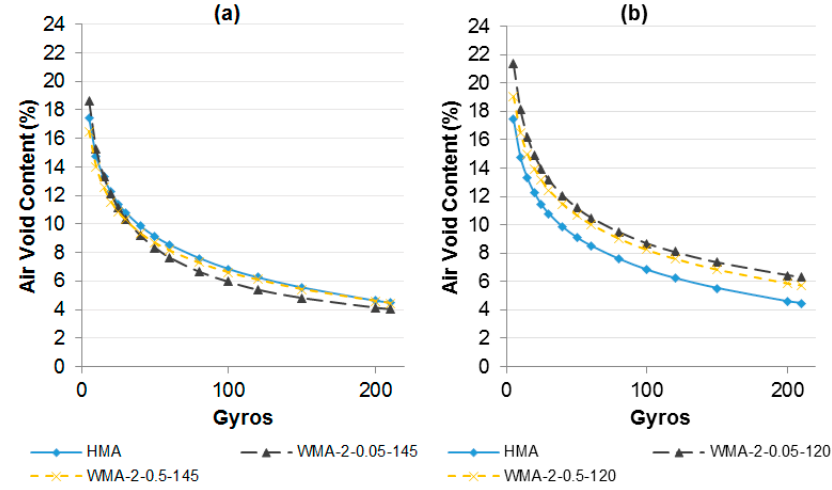
Figure 5. Densification curves for the HMA and WMA with different quantities of additives and manufacturing temperatures. ( a ) 145 °C vs. 165 °C; ( b ) 120 °C vs. 165 °C.